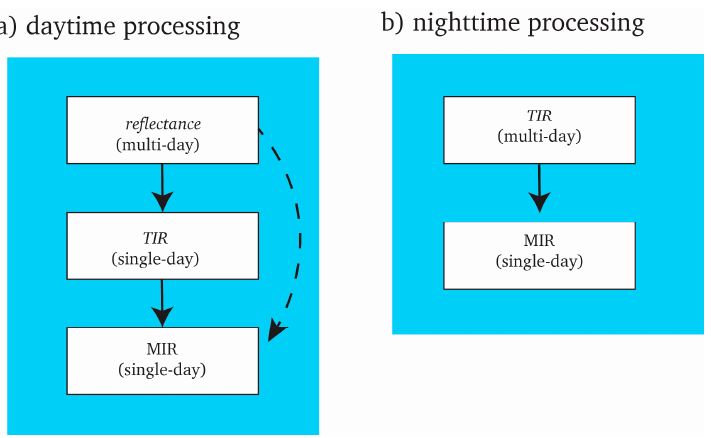
Figure 2. BRIGHT thresholds differ in terms of being taken either over multiple days, or the single (current) day. BRIGHT thresholds (for reflectance, TIR, and MIR) are calculated in a specific order with the results of the preceding threshold variables used to calculate subsequent ones.